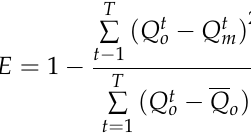
Table 8. Validation results between simulation depth and recorded depth.